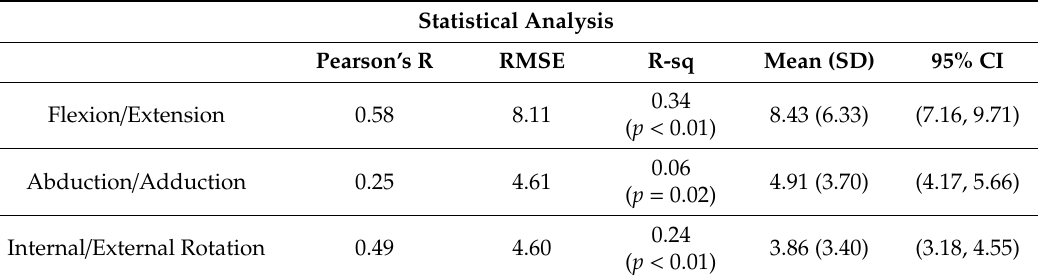
Table 1. Values of the statistical analysis performed on the angles. Mean (SD) and 95% confidence interval(CI)arebasedontheabsolutedi ff erenceinanglemeasurementbetweentheinertialmeasurement unit (IMU) and the motion capture camera. Root mean square error (RMSE) and R-squared (R-sq) value associated with the linear regression model and its significance of fit are also